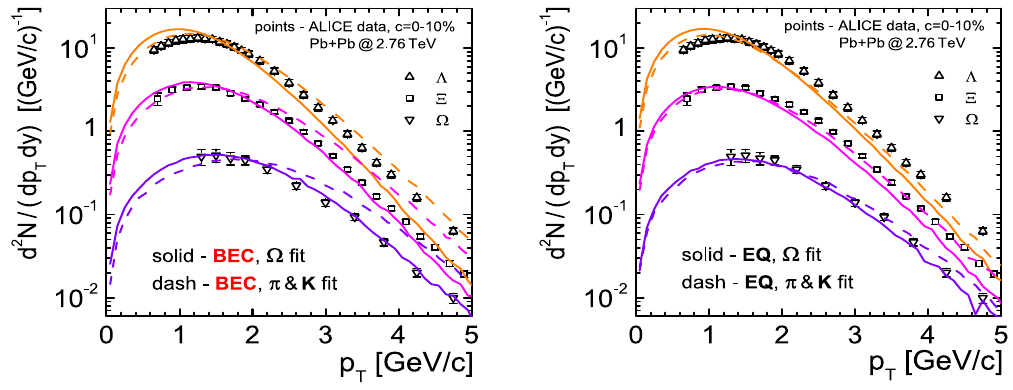
Figure 5. Strange baryons obtained for the hypersurface that was fitted either to pions and kaons, or to Ω baryons.